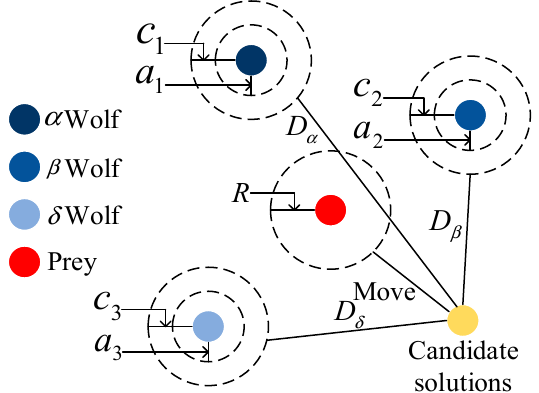
Figure 3. The optimization process of the grey wolf optimization algorithm. Taking α as the most suitable solution, the three wolves are guided by α , β , and δ during the hunting process, and wolf ω follows these three wolves.